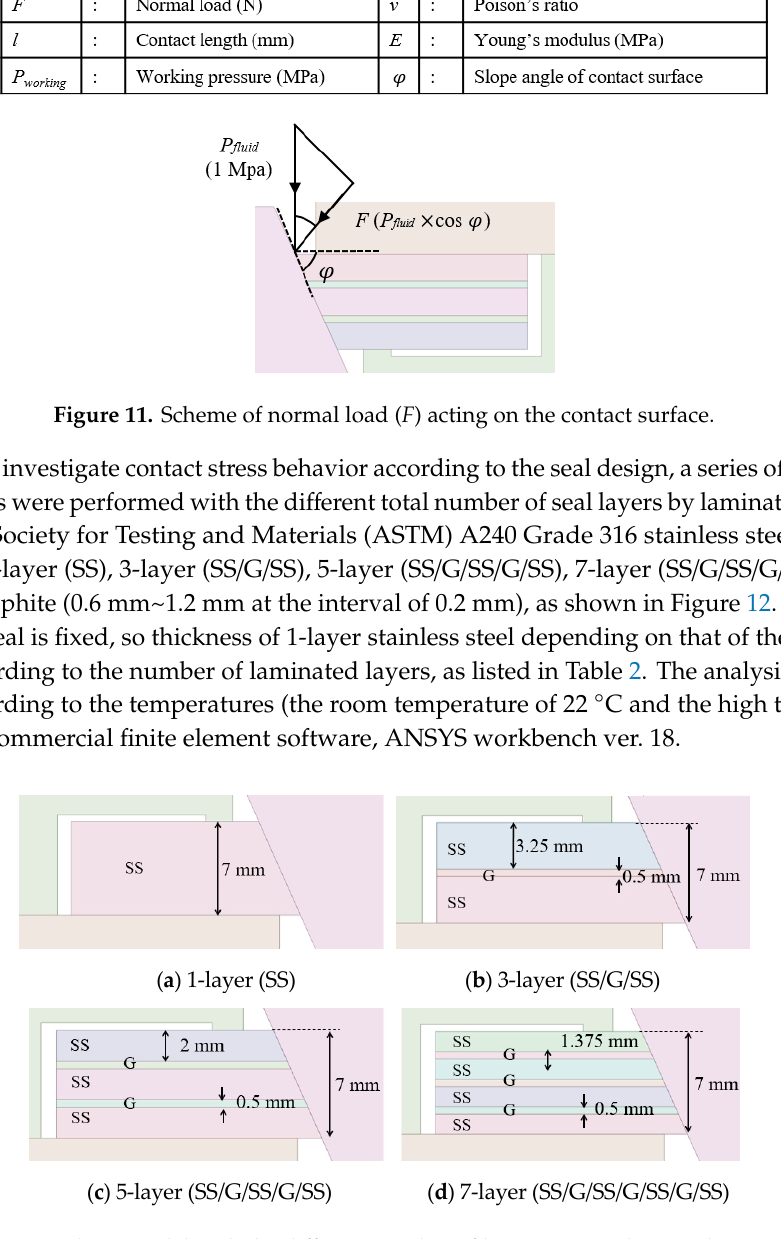
Figure 12. Analysis model with the different number of layer. SS, stainless steel; G, graphite.